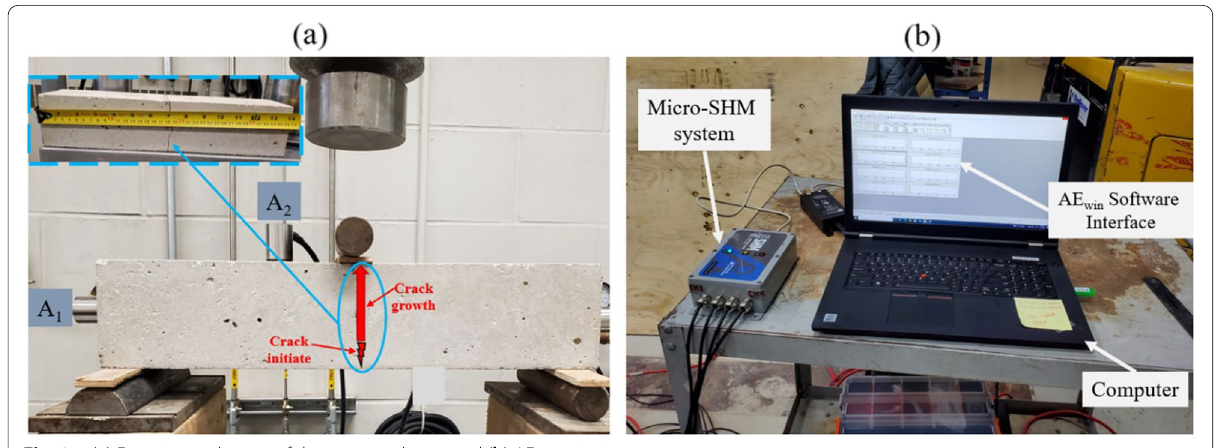
Fig. 25 ( a ) Experimental setup of the concrete beam and ( b ) AE monitoring